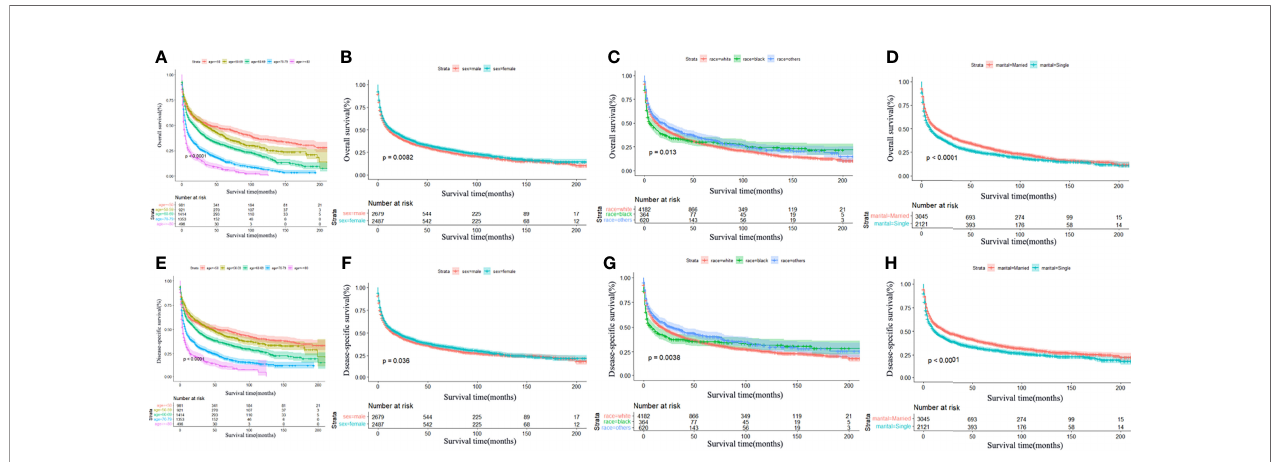
FIGURE 2 | Survival analysis of primary central nervous system lymphoma strati fi ed by age, sex, race, and marital status. Signi fi cant statistical difference was found in OS with age (A) , P < 0.0001; sex (B) , P = 0.0082; race (C) , P = 0.0013; and marital status (D) , P < 0.0001. Signi fi cant statistical difference was found in DSS with age (E) , P < 0.0001; sex (F) , P = 0.036; race (G) , P = 0.0038; and marital status (H) , P < 0.0001. Inferior OS and DSS were signi fi cantly associated with older age, male, black, and single status.